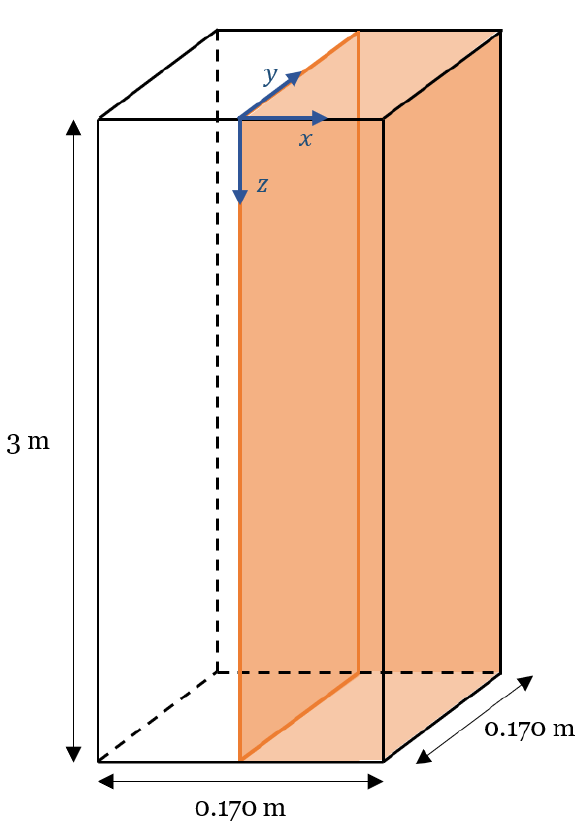
Figure 1. Description of the computational